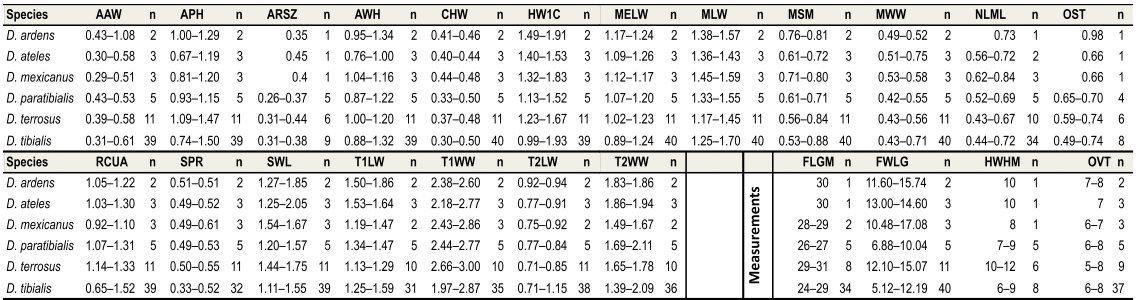
Table 1. Morphometric ratios and measurements, compared for all species of all studied females of Distictus Townes, 1966. Number of measured specimens indicated by n. All the corresponding measurements are provided in the Appendix. Abbreviations as explained in Material and methods, plus the following: ARSZ = areolet maximum height (i.e., anterior to posterior length) [3] / fore wing vein 2m- cu, length [10] ; FLGM = number of flagellomeres [7] ; FWGL = fore wing maximum length [11] ; HWHM = hind wing, number of hamuli [15] ; OVT = number of teeth on the ventral valve of ovipositor [23]